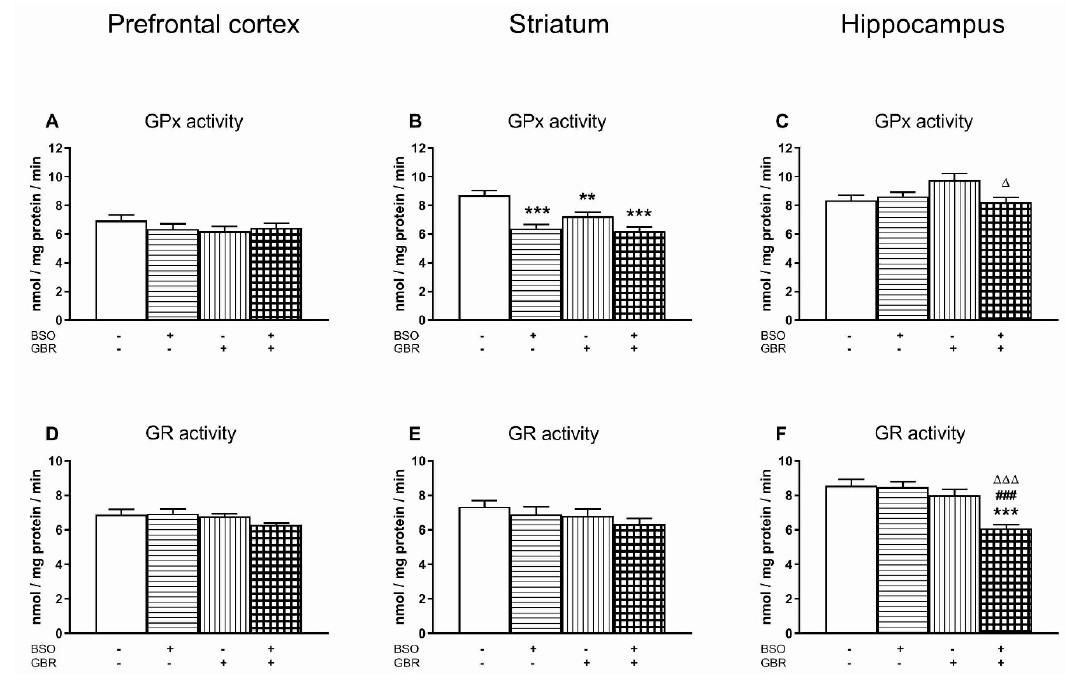
Figure 3. The effect of chronic administration of BSO and/or GBR 12909 on the enzymatic activities of glutathione peroxidase (GPx; 3A–3C ) and glutathione-disulfide reductase (GR; 3D–3F ). The enzymatic activities of GPx and GR are expressed in nmol/mg protein/min (nmol of NADPH oxidized to NADP + by the enzyme during 1 min per mg of protein). The bars representing GPx or GR activity in particular groups show the mean ± SEM, n = 8. Symbols indicate significance of differences according to the Bonferroni post-hoc test, ** p < 0.01, *** p < 0.001 vs. control-; ### p < 0.001 vs. BSO- and ∆ p < 0.05, ∆∆∆ p < 0.001 vs. GBR 12909-treated groups.